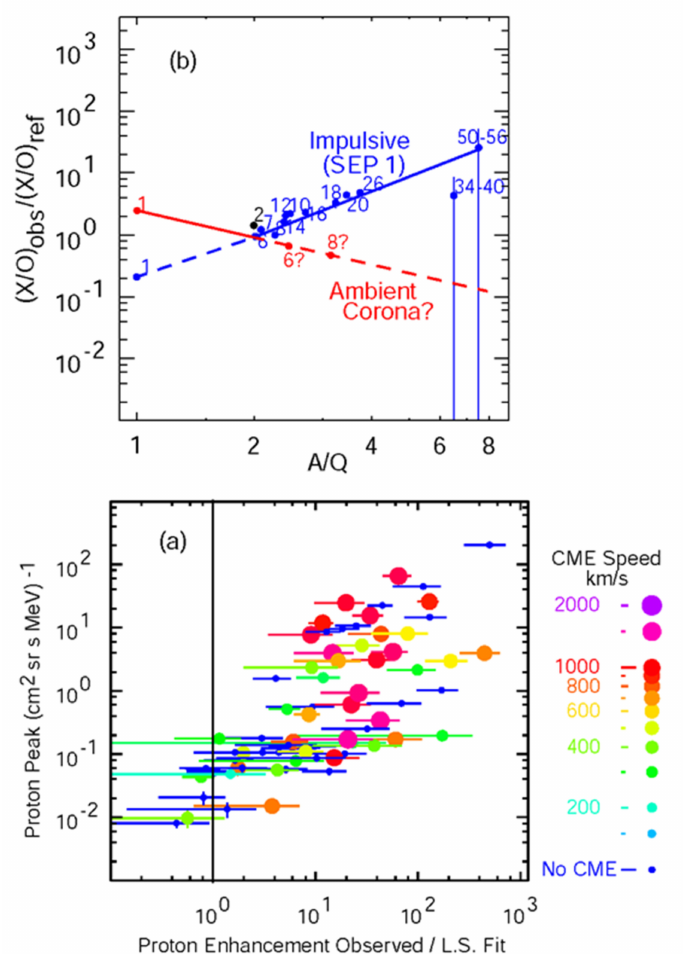
Figure 4. Panel ( a ) shows the peak proton intensity at 2–2.5 MeV vs. the proton excess relative to the Z > 2 power-law fit for 90 impulsive SEP events with the symbol size and color determined by CME speed as shown. Panel ( b ) suggests two possible contributions, impulsive SEP1 seed particles (blue) and ambient coronal seed particles (red), to the plot of enhancement vs. A/Q for the shock-enhanced SEP2 impulsive events